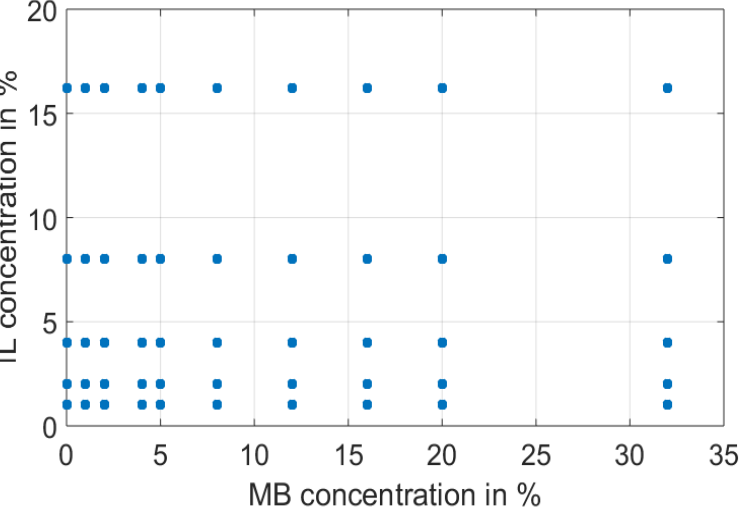
Figure 1. A set of 50 liquid optical phantoms obtained by mixing methylene blue (MB; absorber), intralipid 20% (IL; scatterer) and distilled water (dilution agent) prepared in this study.